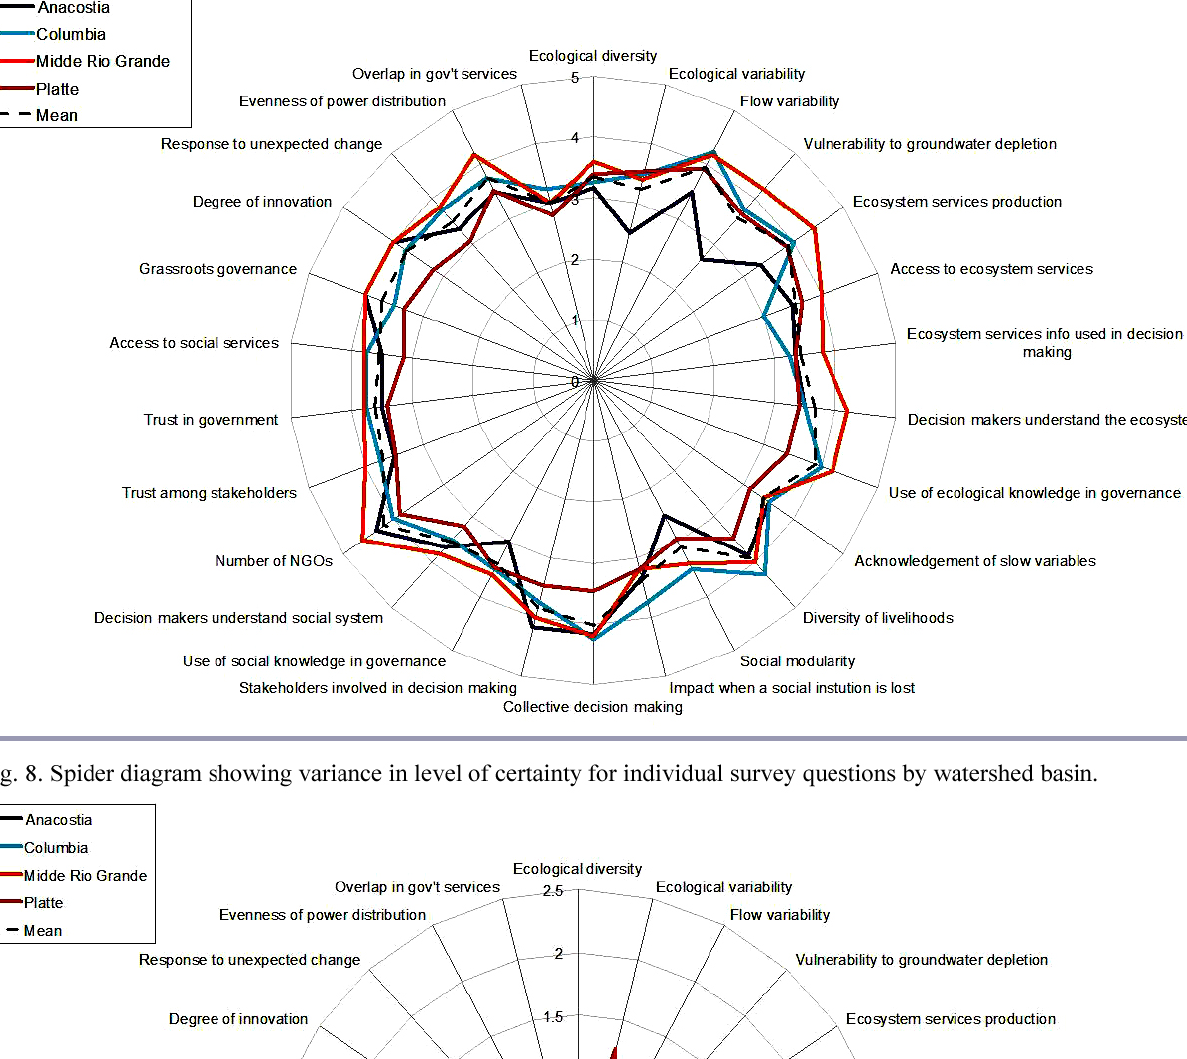
Fig. 7 . Spider diagram showing average certainty in response for individual survey questions by watershed